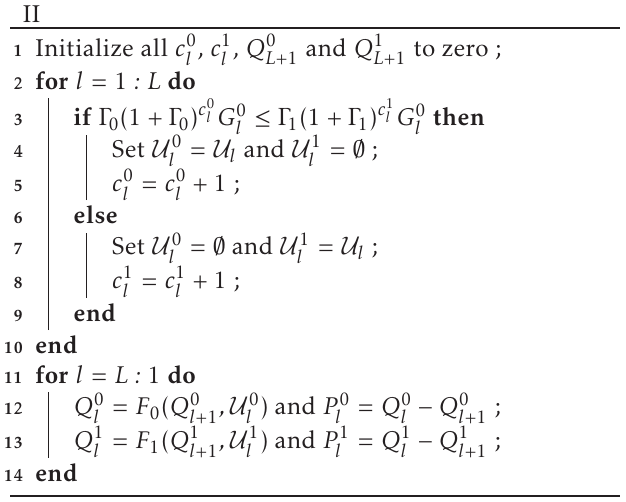
Algorithm 2: Power Allocation Algorithm for